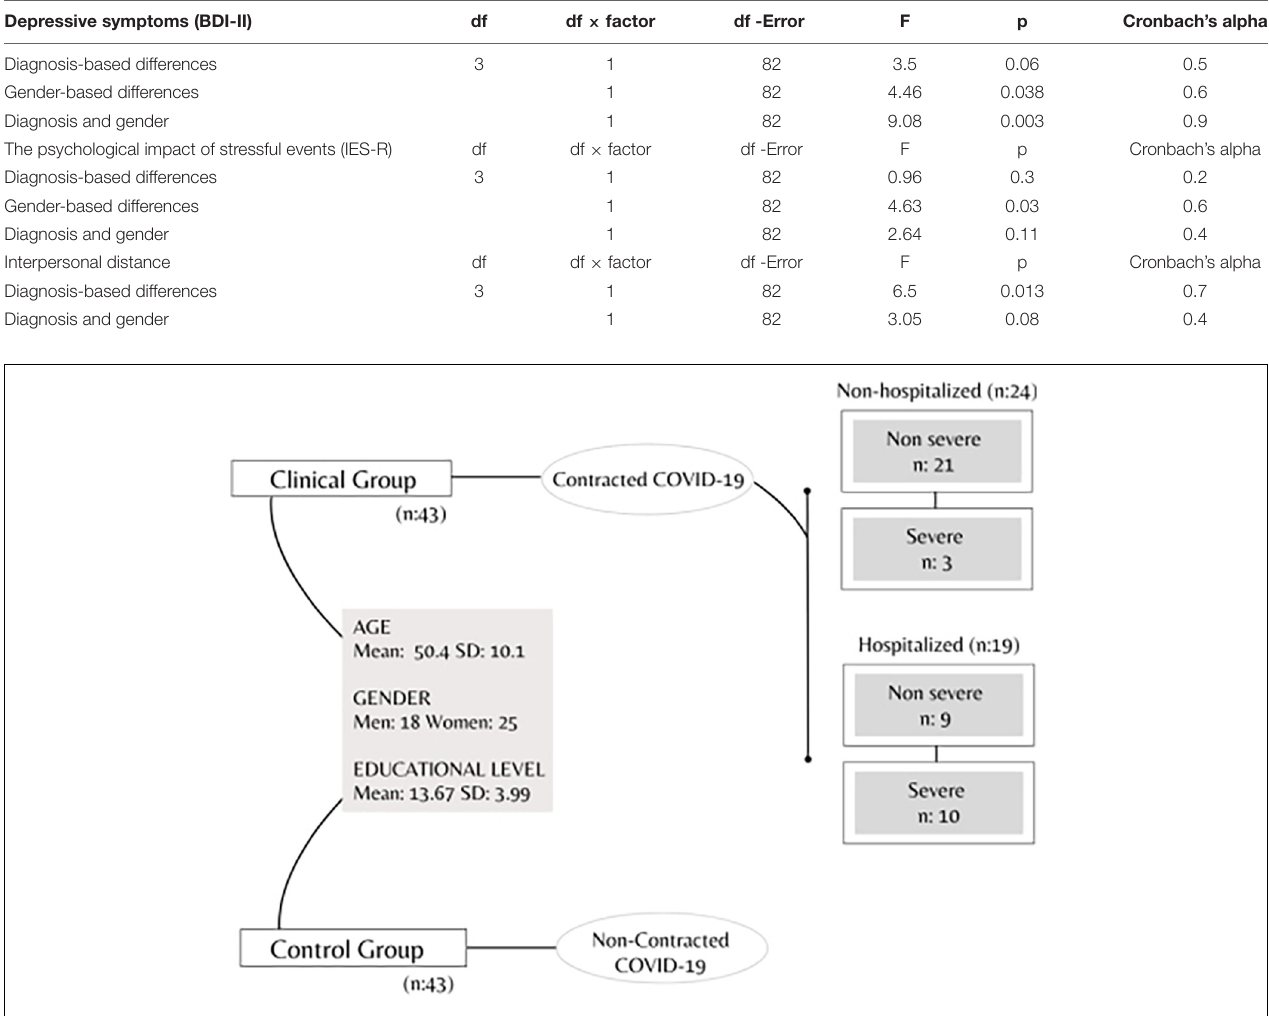
FIGURE 7 | Correlation between BDI-II and IES-R scores within the whole sample.